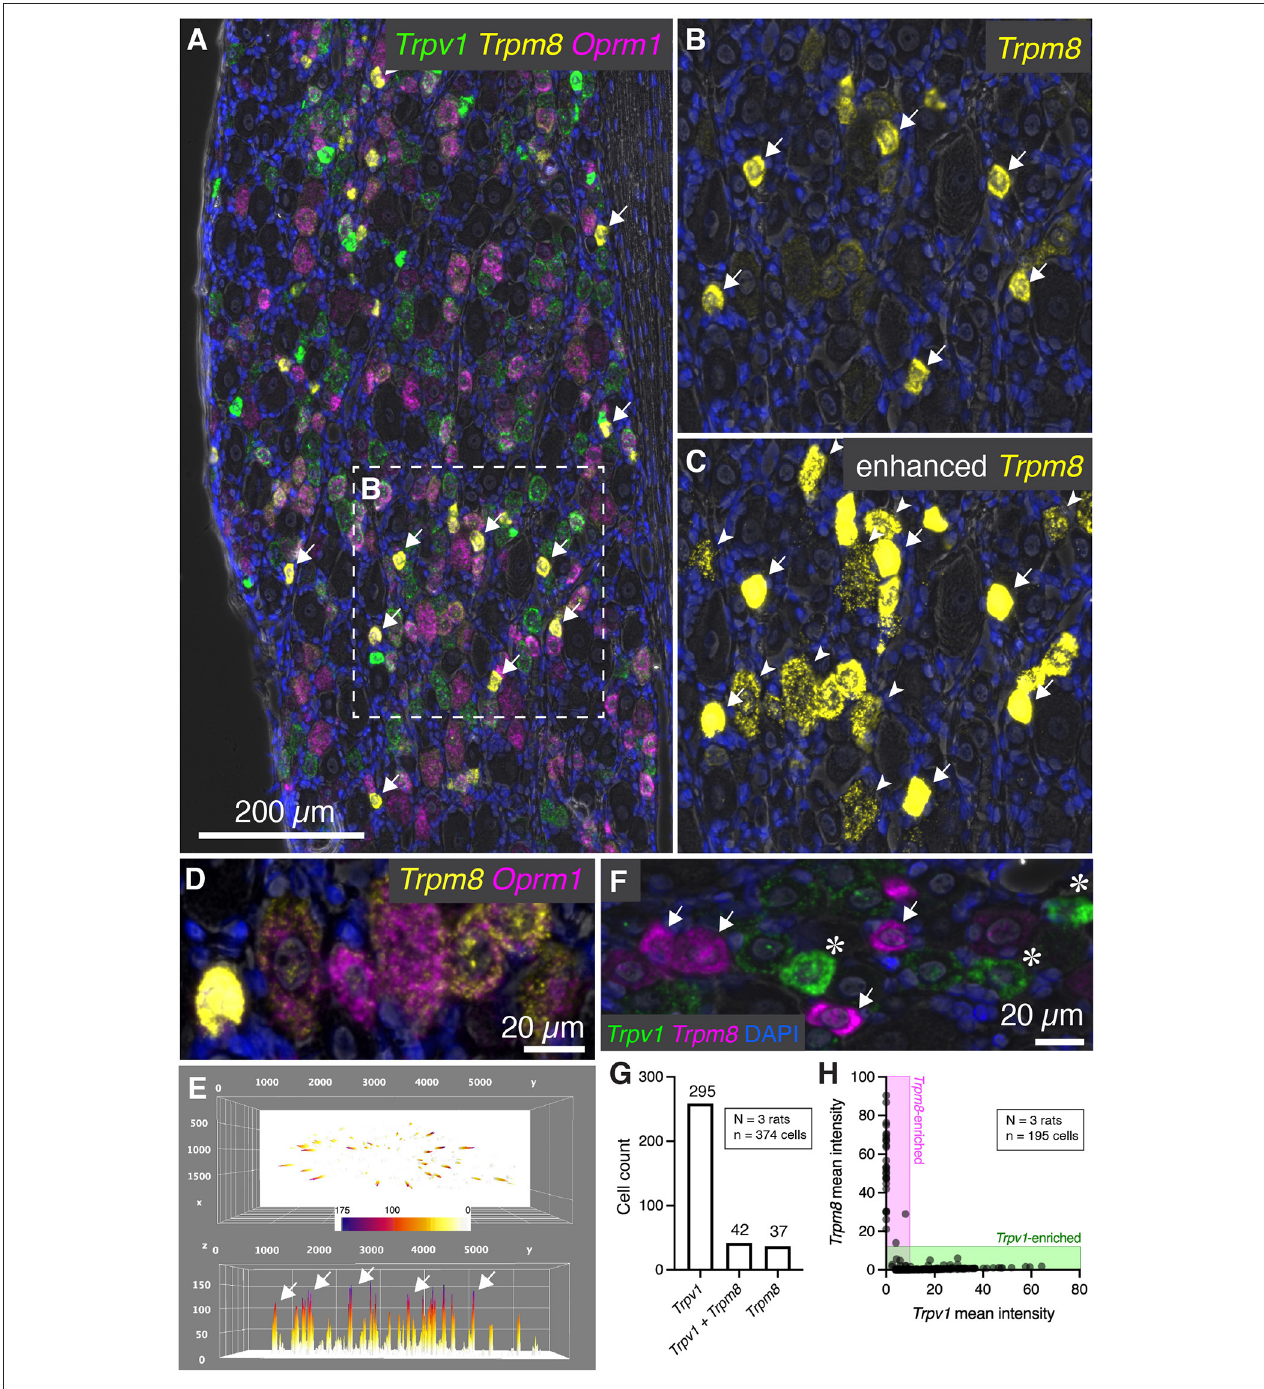
FIGURE 6 | Characterization of Trpm8 expression levels in rat DRG. To assess the overlap between hot and cold thermal nociceptive transducing ion channels, multiplex fluorescent hybridization was performed for Trpv1 , and Trpm8 alongside Oprm1 . (A) Panoramic view of triple-labeled rat DRG. (B) Cells positive for Trpm8 were brightly labeled small diameter neurons (white arrows). However, a number of other neurons were also visible with lower levels of Trpm8 . (C) Similar to what was performed for Trpv1 , enhancement of the image saturates the high-expressing Trpm8 neurons, but allows for visualization of the much lower intensity staining observed in other neurons. Note that these neurons still have clear punctate staining pattern and that this staining pattern was reproduced with a different probe for confirmation ( Supplementary Figure 4 ). (D) Another characteristic of Trpm8 neurons is that 100% of them co-express Oprm1 to some extent. This relationship is visualized in the representative field. (E) A surface plot of Trpm8 expression levels is shown with arrows pointing to the highest expressing Trpm8 lower peaks span a range of expression levels. (F) The relationship between Trpv1 and Trpm8 was further explored by quantifying levels of expression of these